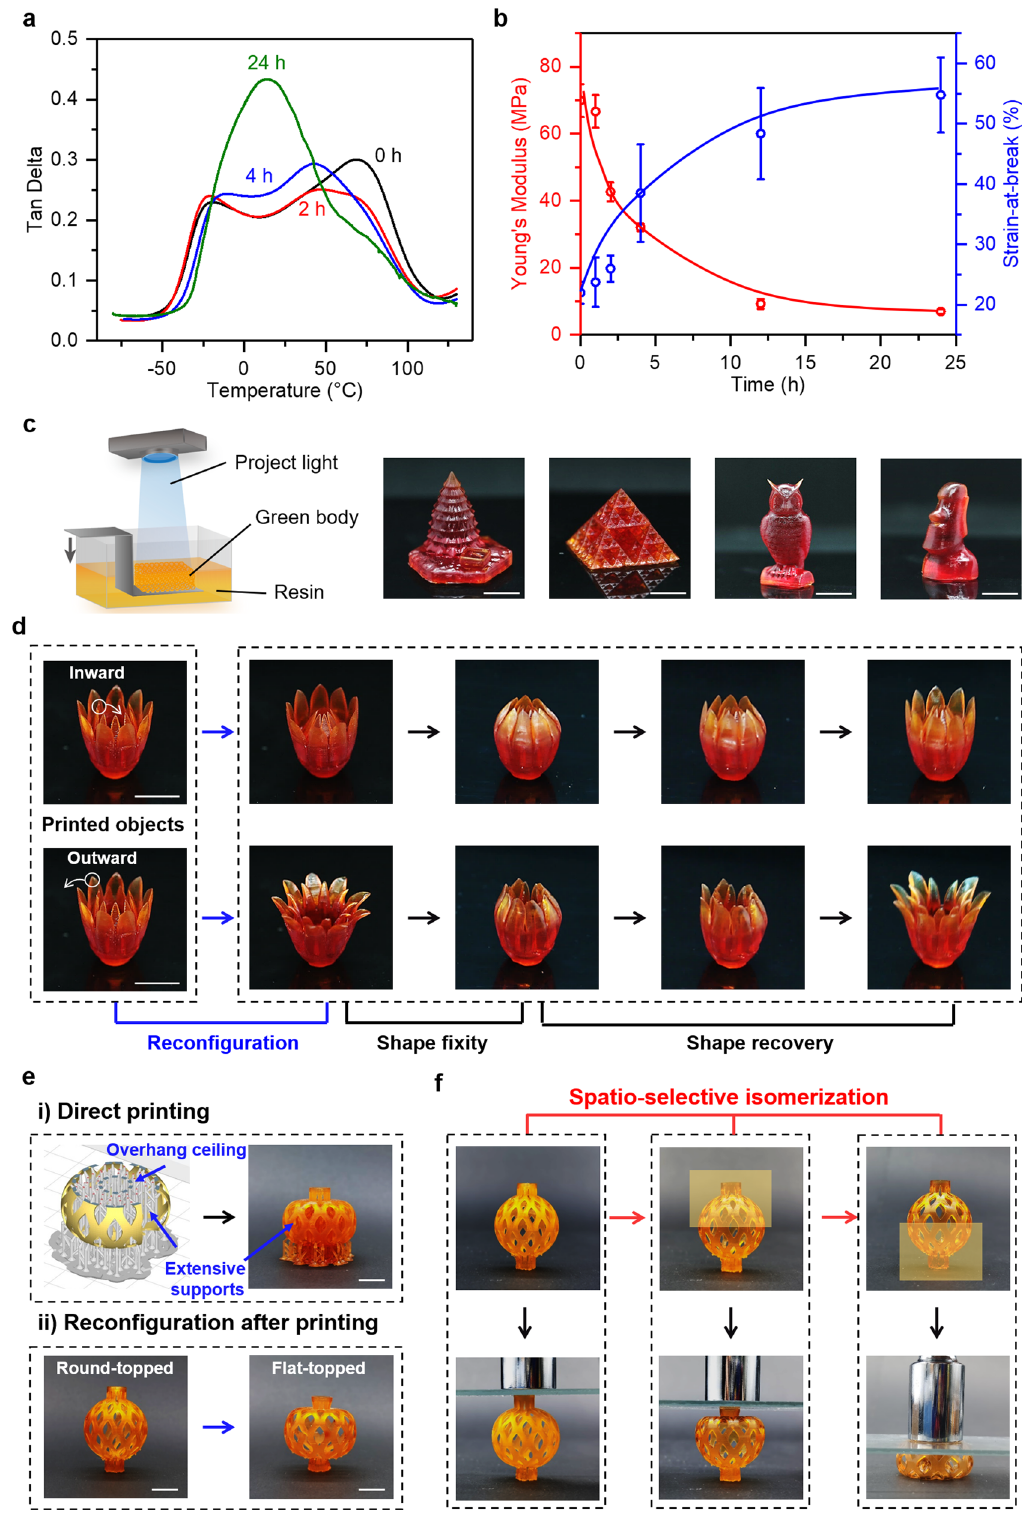
Fig. 4 | Shape and mechanical reprogrammability for digital light 3D printed HUBM-co-PPGA. a Evolution of thermal transitions upon annealing at 120°C. b Evolution of mechanical properties upon annealing at 120°C. c Schematic illus- tration of the printing process and photos of the 3D printed objects. d Permanent shape recon fi guration with the printed fl ower petals being permanently deformed inward or outward (80°C, 60min) and their corresponding shape memory